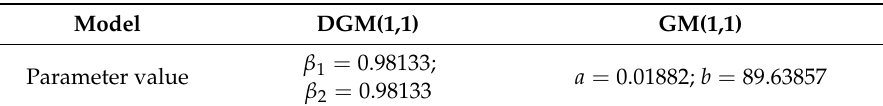
Table 4. Values of the parameters of the DGM(1,1) model and GM(1,1).